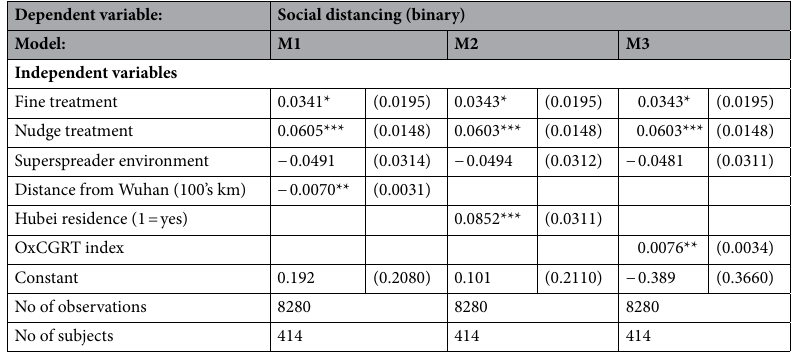
Table 1. Main regression results for individual propensity to social distance. Standard errors (reported in parentheses) are clustered at the group level. Significance level: *** p < 0.01, ** p < 0.05, * p < 0.1. (a) All regressions use Linear Probability Model. (b) All models include the following controls: gender dummy (female = 1), age, years of education, employed or entrepreneur dummy (yes = 1), religious dummy (yes = 1), risk score (as captured by BRET), prosocial values (as captured by SVO; yes = 1). (c) To account for learning effects, we discard the first 10 rounds of baseline and intervention, and only consider 20 remaining rounds per subject. See Materials and Methods for details. (d) One subject did not complete the post experimental questionnaire and